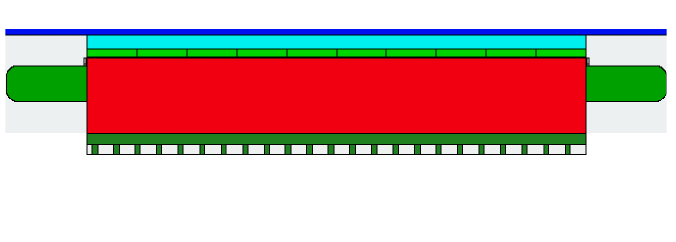
Figure 12. Water ‐ cooling channel model